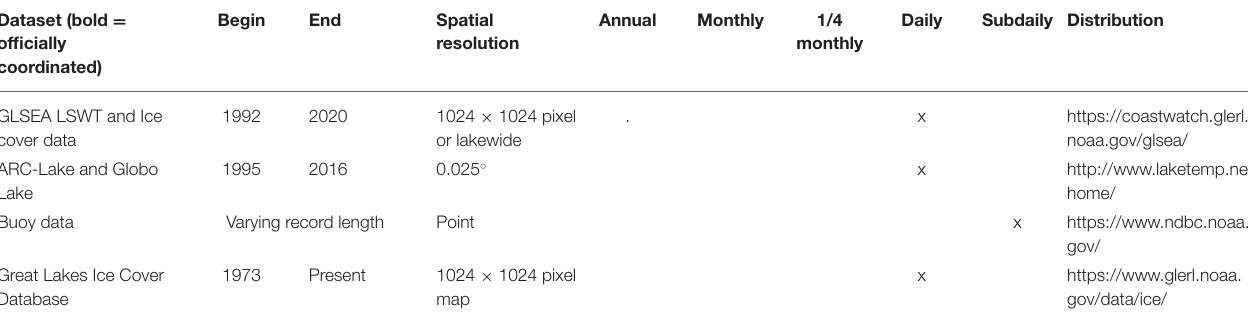
TABLE 4 | Lake surface water temperature (LSWT) and ice cover data products. Dataset (bold = officially